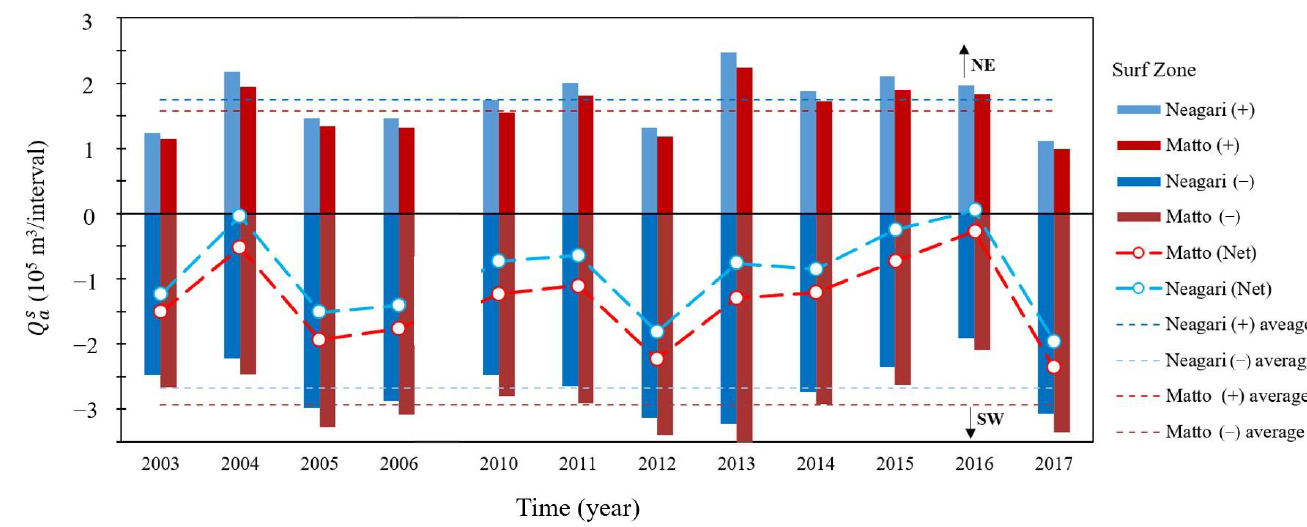
Figure 7. Cumulative and net sediment transport in the surf zone, both cumulative and net value in each interval (calculated approximately once a year based on the date of bathymetric surveys conducted annually). Since sediment moves in both directions, the positive and negative terms are displayed in addition to the value’s sum.